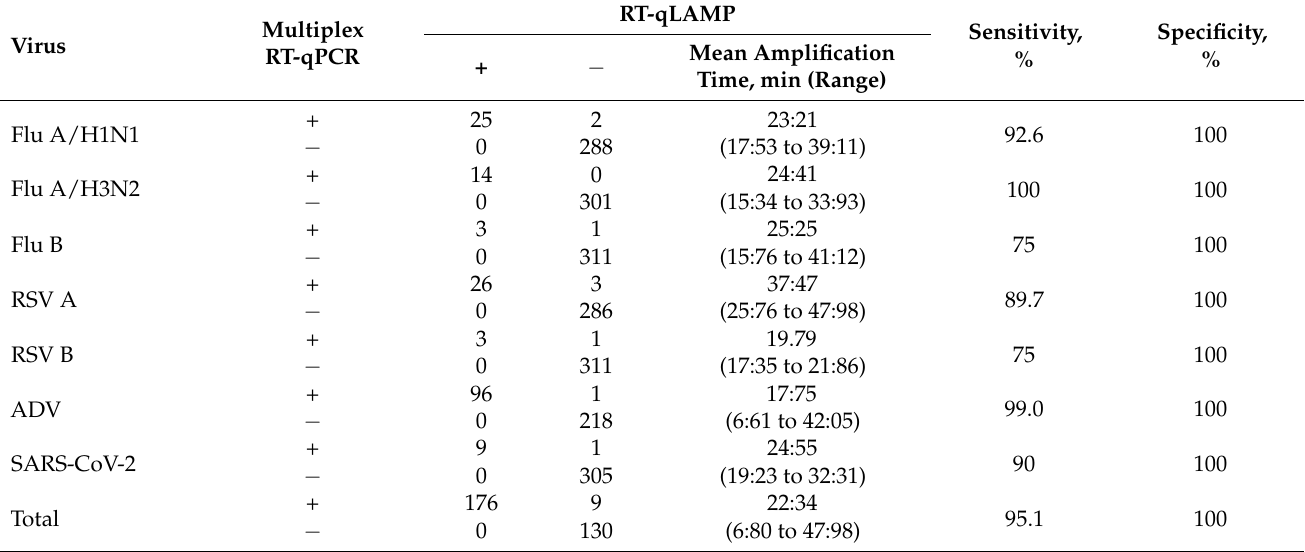
Table 2. Comparison of the results between the developed RT-qLAMP and RT-qPCR performed concurrently.